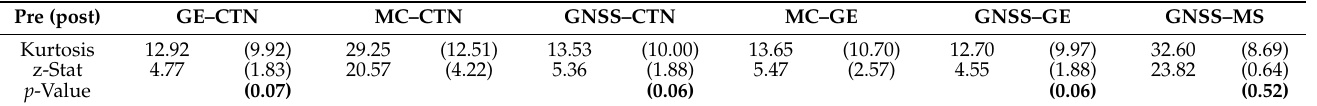
Table 4. Multivariate normality testing (Mardia) for kurtosis of the pairs ∆ E – ∆ N . The degree of freedom (df) = 4. Values after outliers’ removal are reported between parentheses. p -Values < 0.02 are omitted. The kurtosis and the test statistic z-stat are also reported. The resulting bivariate normal distributions are highlighted in bold.